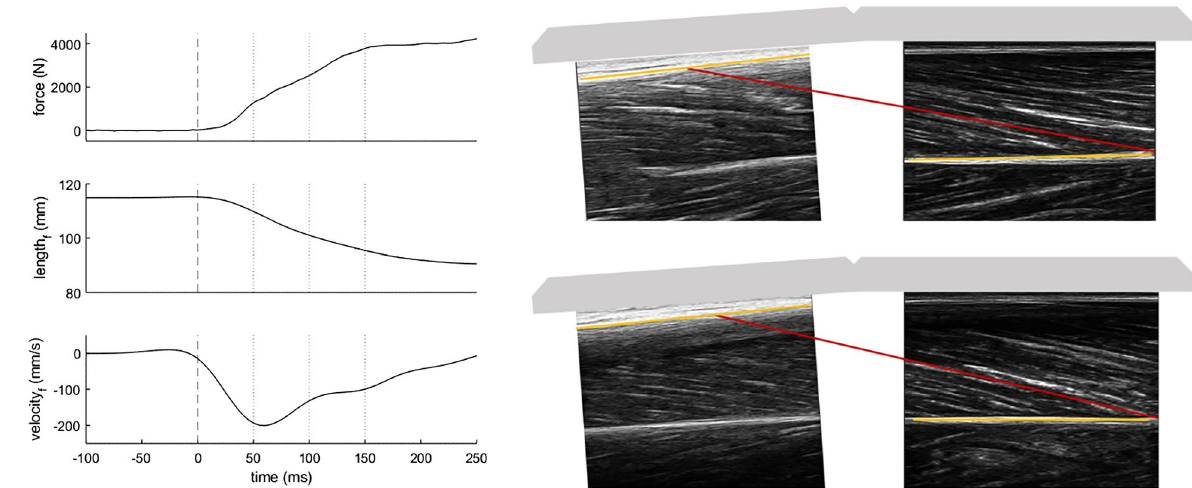
Figure 1. Individual patterns of force, fascicle length (length f ) and fascicle velocity (velocity f ) during explosive contractions (left side). Onset of the contraction is shown with the dashed line and 50 ms timepoints/intervals for the analysis are displayed with dotted lines. Changes in force and fascicle length and mean fascicle velocity were calculated for each interval. Example images of longitudinal scans of the vastus lateralis muscle with fascicle length measurements (right side) at force onset (upper panel) and 150 ms after onset (lower panel) with a scaled illustration of the ultrasound transducer